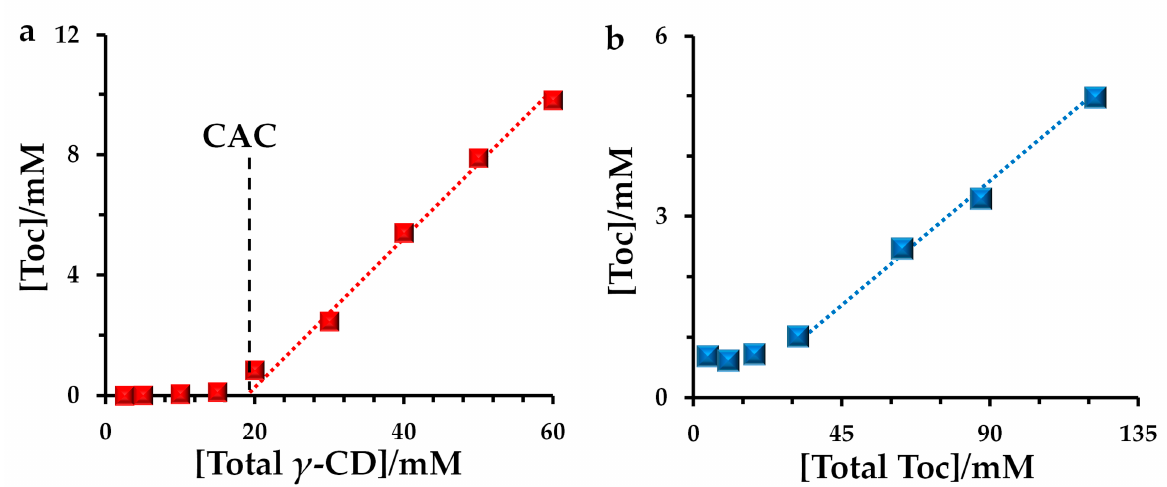
Figure 3. Contained vitamin E (Toc) concentration in I as the function of ( a ) initial γ -cyclodextrin (CD) concentrations and ( b ) added total amount of Toc. For ( a ), the added amount of Toc was 1.2 times mole of γ -CD. For ( b ), the γ -CD concentration was constant at 30 mM.